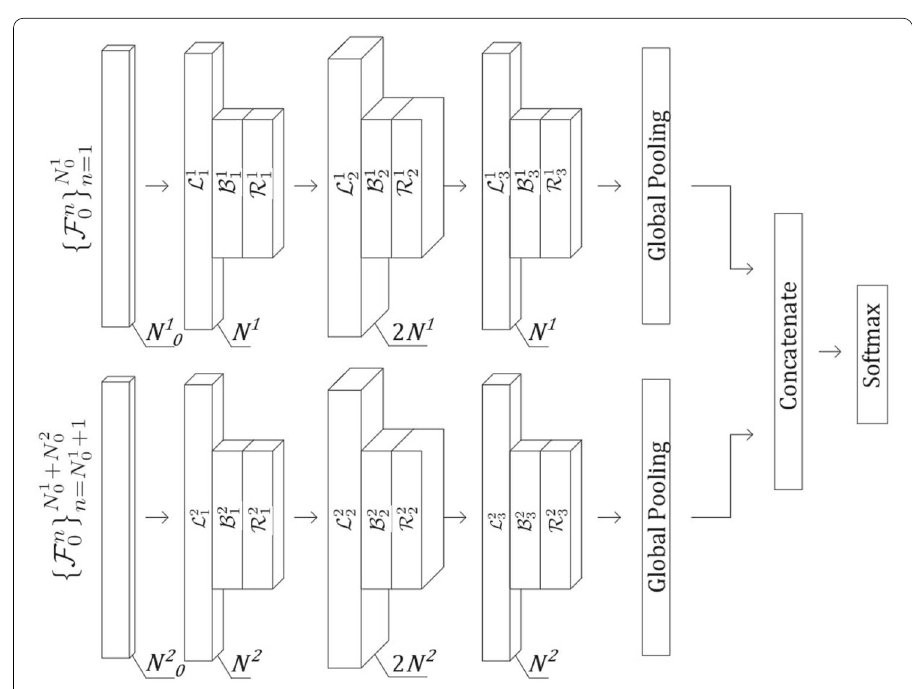
and N 2 represent the number of input 0 0